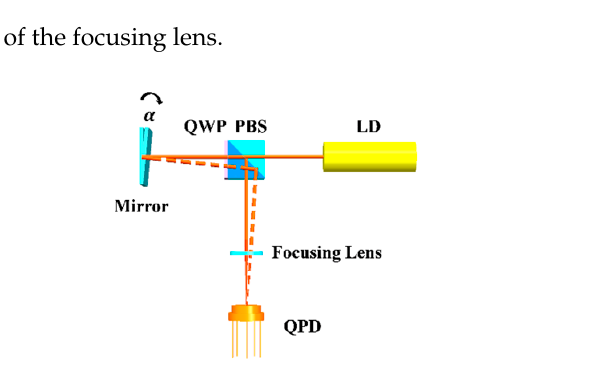
Figure 1. Optical configuration of the 2D angle sensor. Abbreviations: QWP = quarter-wave plate; PBS = polarizing beam splitter; LD = laser diode; QPD = quadrant photodetector.